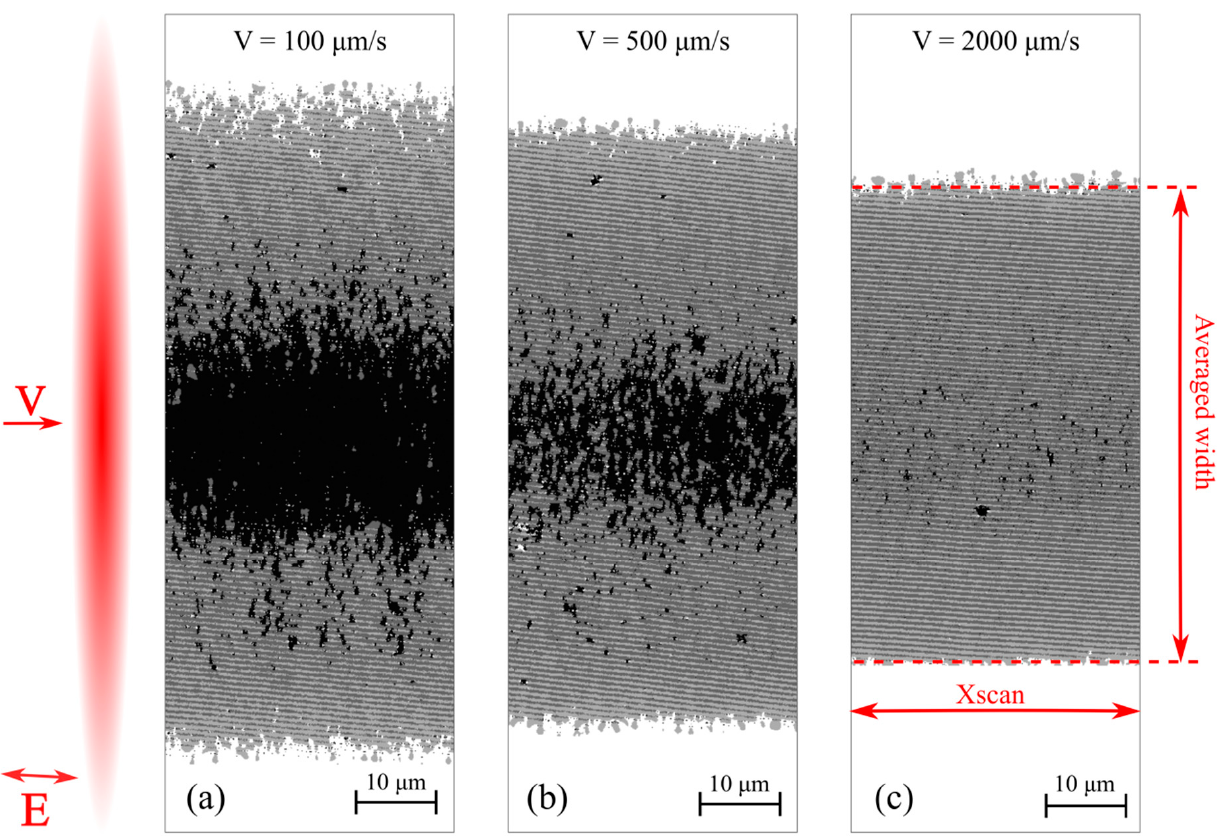
Figure 2. Processed SEM images formed in air at a power of 250 mW and different scanning speeds: 100 µ m/s ( a ), 500 µ m/s ( b ), 2000 µ m/s ( c ). The inset shows schematically the astigmatic beam, directions of scanning and polarization.